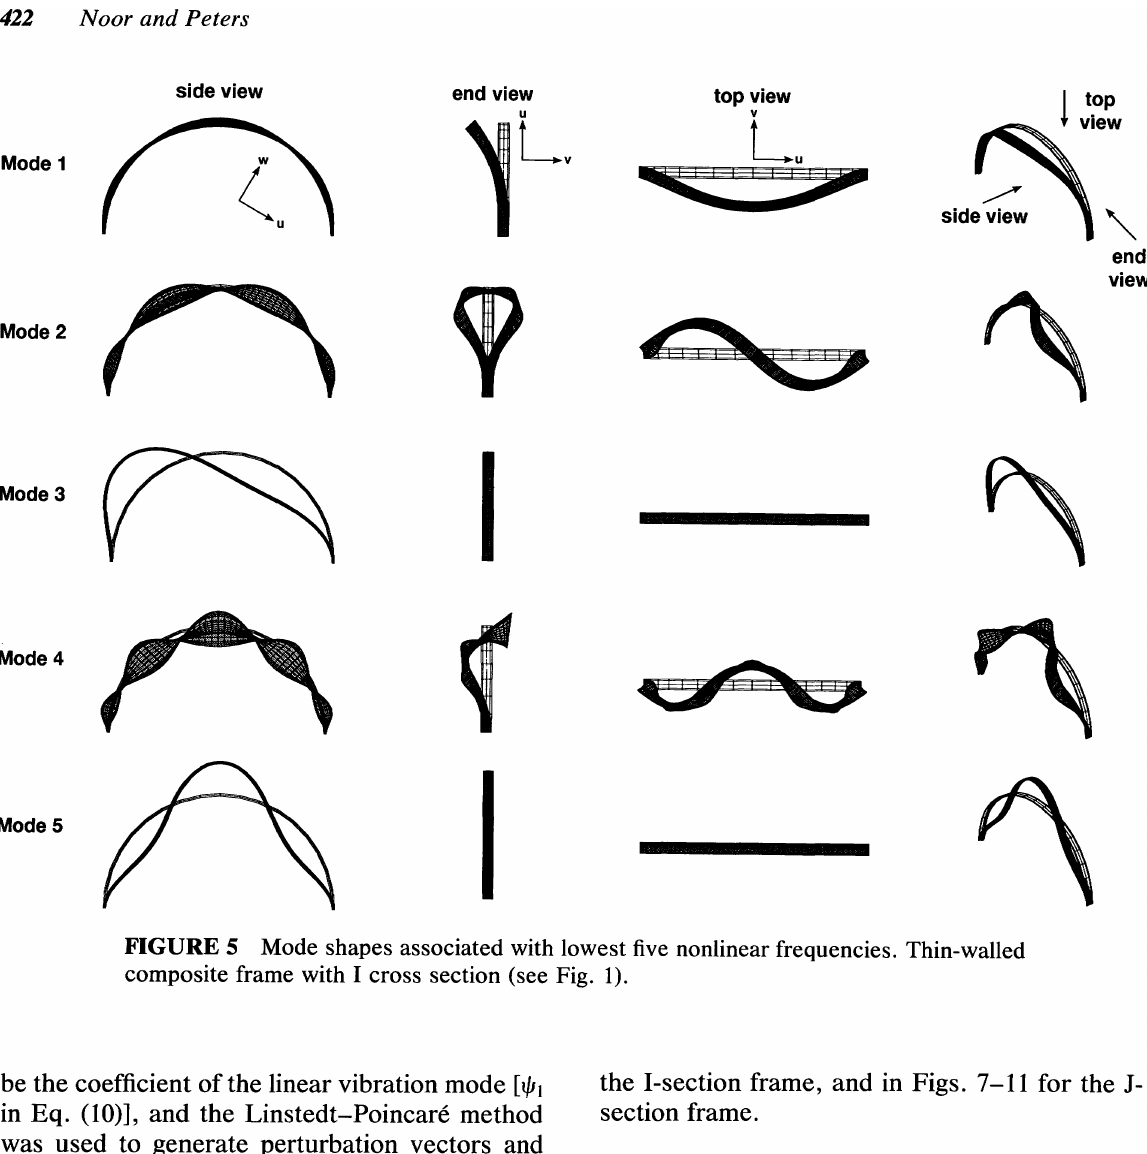
FIGURE 5 Mode shapes associated with lowest five nonlinear frequencies. Thin-walled composite frame with I cross section (see Fig.